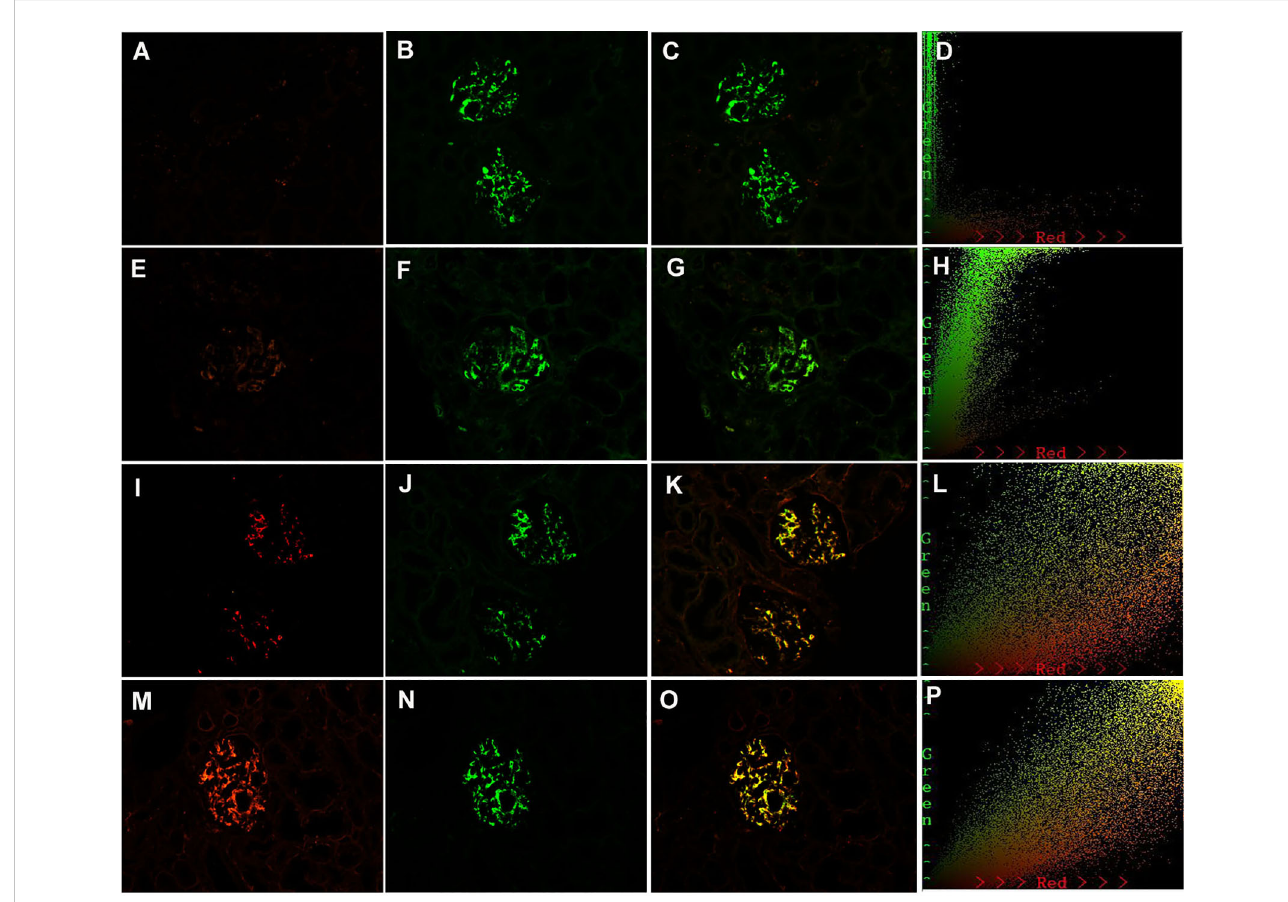
FIGURE 4 Paraf fi n-embedded sections for of galactose-de fi cient immunoglobulin A1 (Gd-IgA1) and immunoglobulin A (IgA) by immuno fl uorescence in patients with immunoglobulin A nephropathy (IgAN). Granular-positive staining of Gd-IgA1 negative (A) , 1+ (E) , 2+ (I) , 3+ (H) by immuno fl uorescence along the glomerular mesangial and capillary area in the same section with IgA. Granular-positive staining of IgA (B, F, J, N) by immuno fl uorescence along the glomerular mesangial and capillary area in patients with IgAN. (G, K, O) Gd-IgA1 and IgA colocalized completely along the glomerular mesangial and capillary area. The corresponding two-dimensional (2D) fl uorograms have been included to con fi rm the degree of colocalization. (H: Pearson ’ s correlation = 0.890362, overlap coef fi cient = 0.902370; (L) : Pearson ’ s correlation = 0.851353, overlap coef fi cient = 0.855853; (P) : Pearson ’ s correlation = 0.928907, overlap coef fi cient = 0.925787). (A – C) , (E – G) , (I – K) , and (M – O) : original magni fi cation ×200.